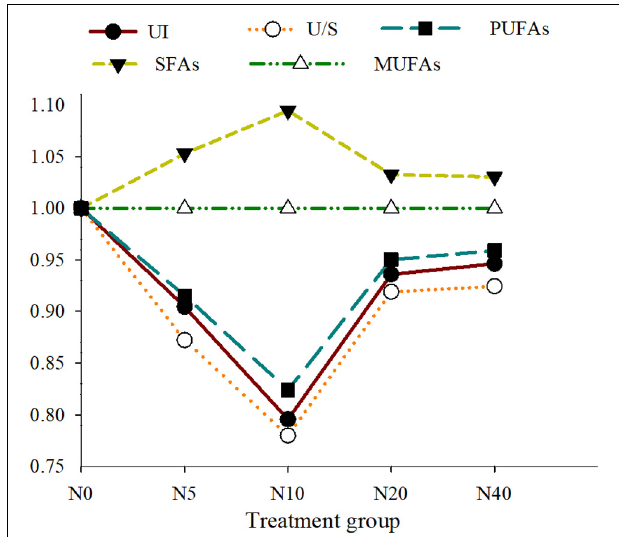
FIGURE 3 | Changes in UI, U/S, SFA, PUFA, and MUFA of P. damicornis larvae with different nitrate concentrations. Note: Each value is the ratio of the different treatment groups to the N0 group. MUFA, monounsaturated fatty acid; PUFA, polyunsaturated fatty acid; SFA, saturated fatty acid; UI, unsaturation index; U/S, unsaturated to saturated fatty acid ratio.